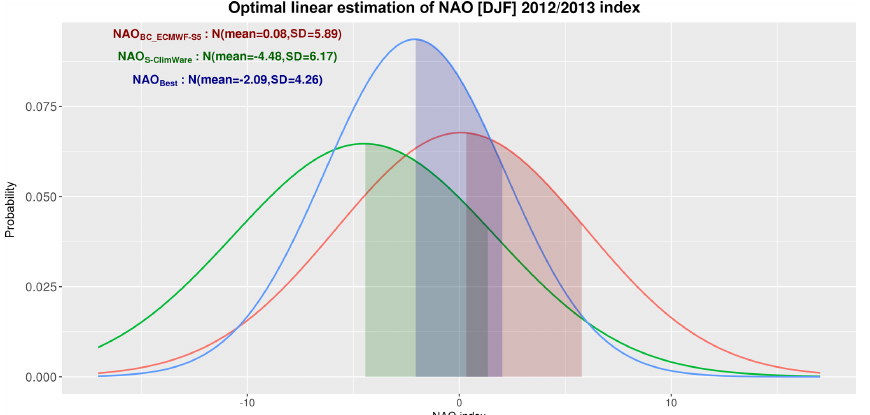
Figure 3. Adjusted Gaussian pdf representing the forecasted NAO [DJF] index distribution for winter 2012–2013 by: (i) the bias corrected ECMWF System 5 (red), (ii) S-ClimWare empirical system (green), and (iii) the a posteriori Best NAO estimate